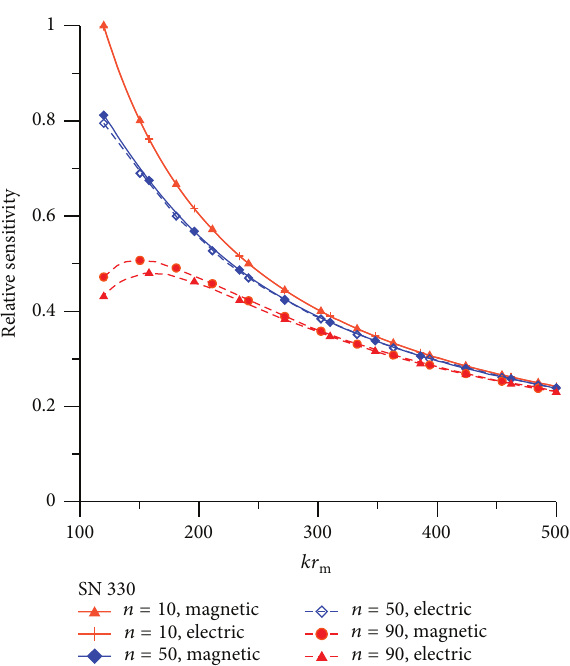
Figure 4: Huygens probe, external case.